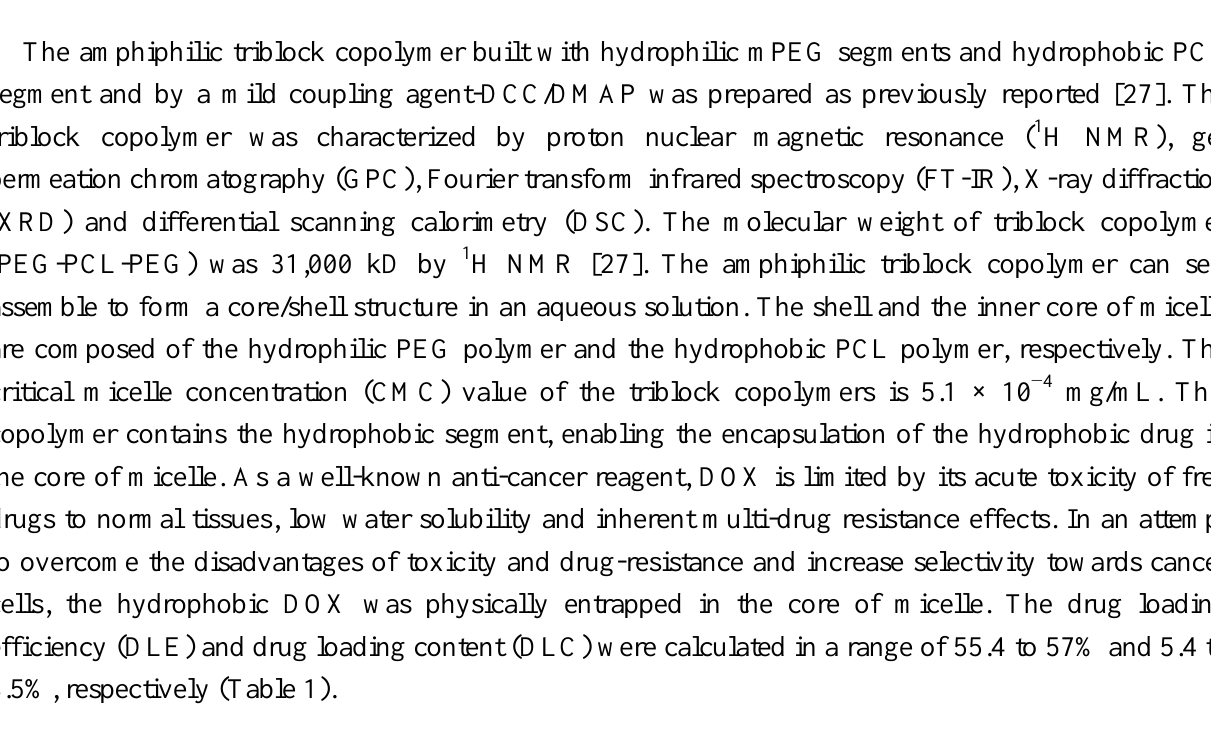
Table 1. Characteristics of prepared DOX-loaded PEG-PCL-PEG